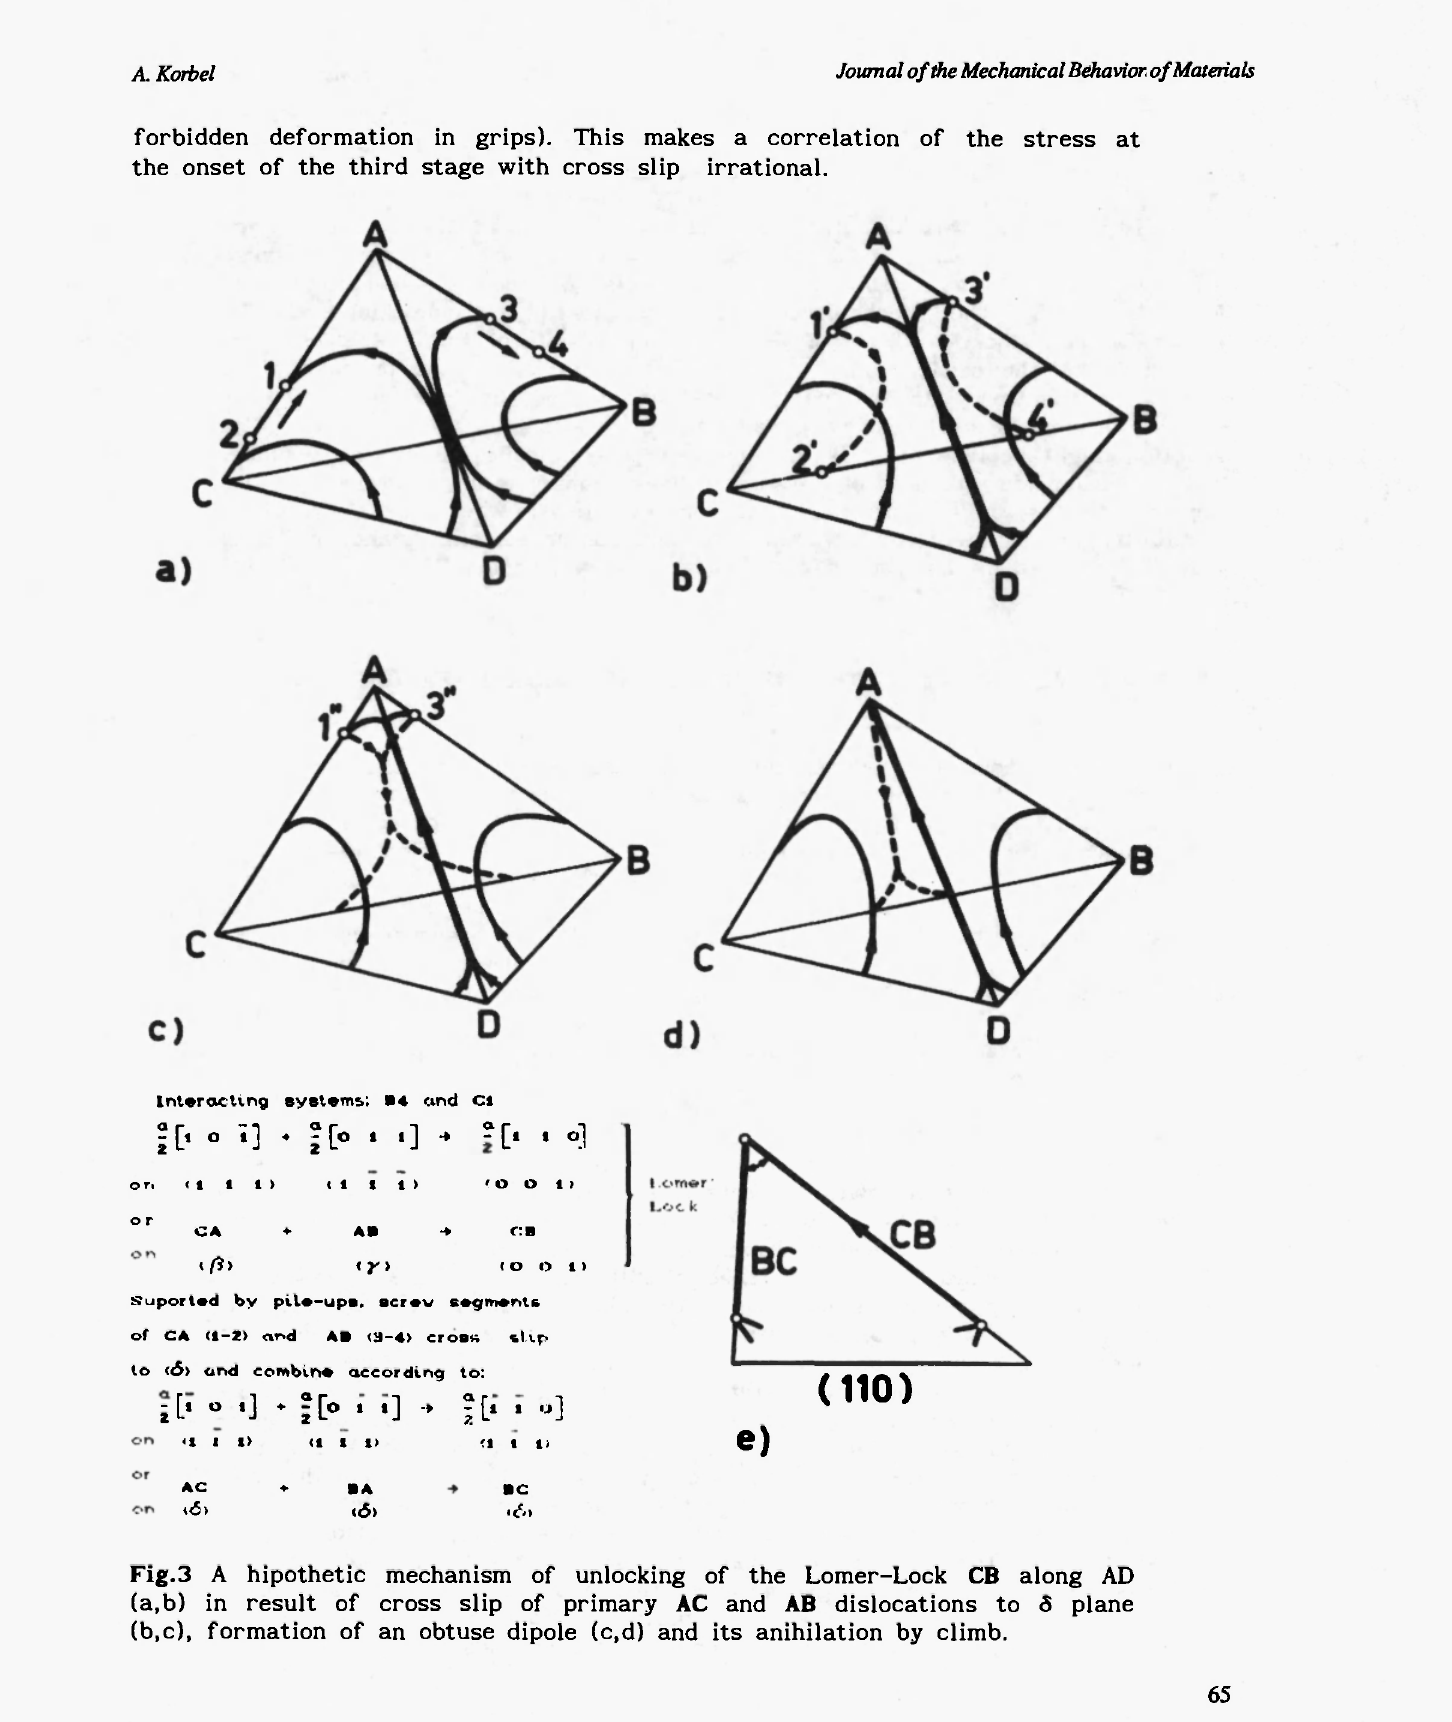
Fig. 3 A hipothetic mechanism of unlocking of the Lomer-Lock CB along AD (a,b) in result of cross slip of primary AC and AB dislocations to δ plane (b,c), formation of an obtuse dipole (c,d) and its anihilation by